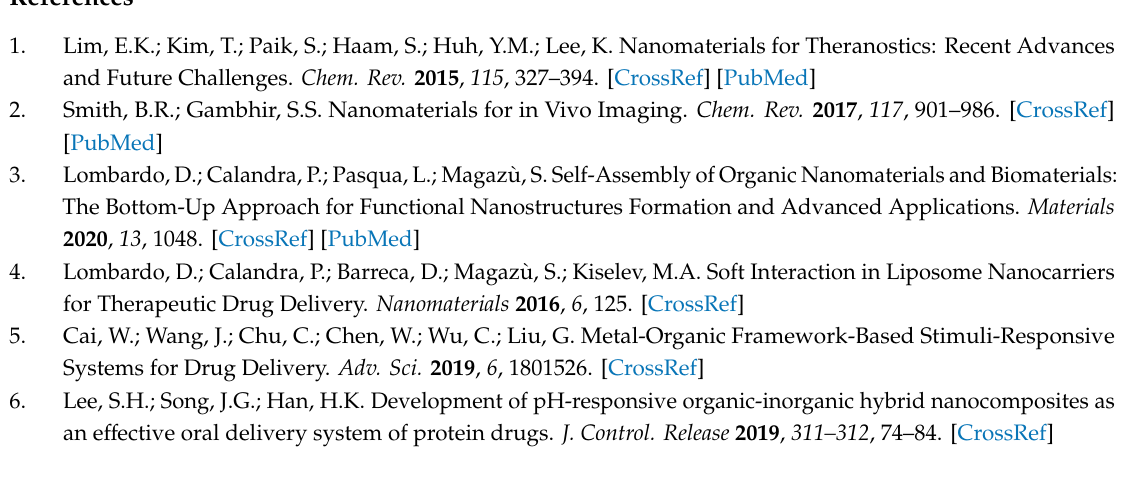
Figure S1: IR spectra of Fe 3 O 4 nanoparticles; Figure S2: IR spectra of microcrystalline cellulose (MCC); Figure S3: IR spectra of sulfonated cellulose (SC); Figure S4: IR spectra of SC@Fe 3 O 4 ; Figure S5: IR spectra of sulfonated cellulose @ Fe 3 O 4 composite after absorption; Table S1: Assignment resume of the vibrational peaks; Figure S6: Piperidine calibration curve; Figure S7: N , N -Diisopropylethylamine calibration curve; Figure S8: 1,5-Dimethylhexylamine calibration curve; Figure S9: 2-Ethylhexylamine calibration curve; Figure S10: Octylamine calibration curve; Figure S11: 4-Methoxybenzylamine calibration curve; Figure S12: Aniline calibration curve; Figure S13: N -Methylaniline calibration curve; Figure S14: 2,4-Dimethylaniline calibration curve; Figure S15: N , N -Diethylaniline calibration curve; Table S2: Peak data; Table S3: GC analytical method; Figure S16: Chromatogram of piperidine; Figure S17: Chromatogram of N , N -diisopropylehtylamine; Figure S18: Chromatogram of 1,5-dimethylhexylamine; Figure S19: Chromatogram of 2-ethylhexylamine; Figure S20: Chromatogram of octylamine; Figure S21: Chromatogram of 4-methoxybenzylamine; Figure S22: Chromatogram of aniline; Figure S23: Chromatogram of N -methylaniline; Figure S24: Chromatogram of 2,4-dimethylaniline; Figure S25: Chromatogram of N , N